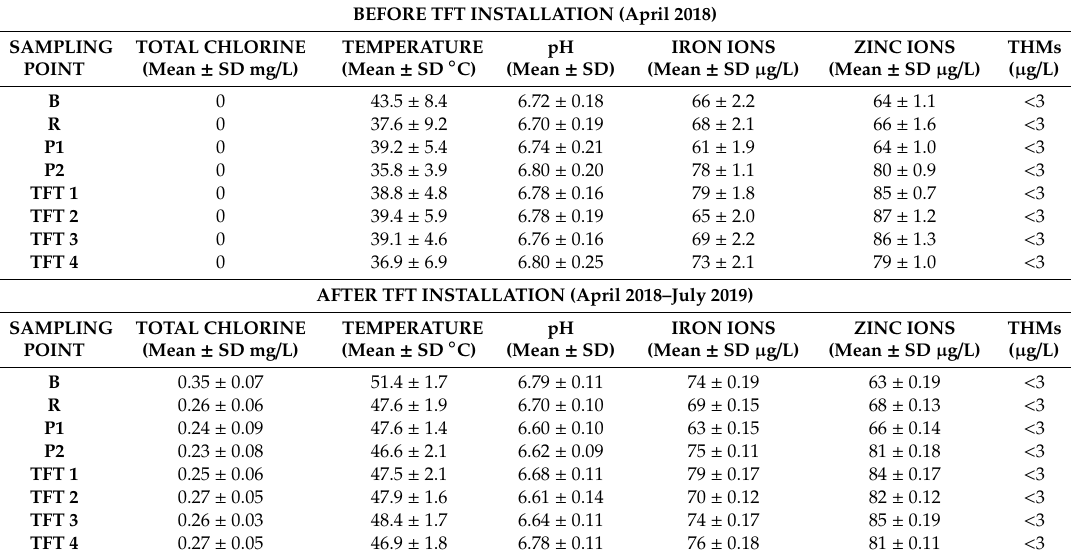
Table 2. Mean values of physical–chemical and chemical parameters assessed at each sampling points before and after TFT installation in Hospital 2. B = boiler; R = recirculation; P1 = point 1; P2 = point